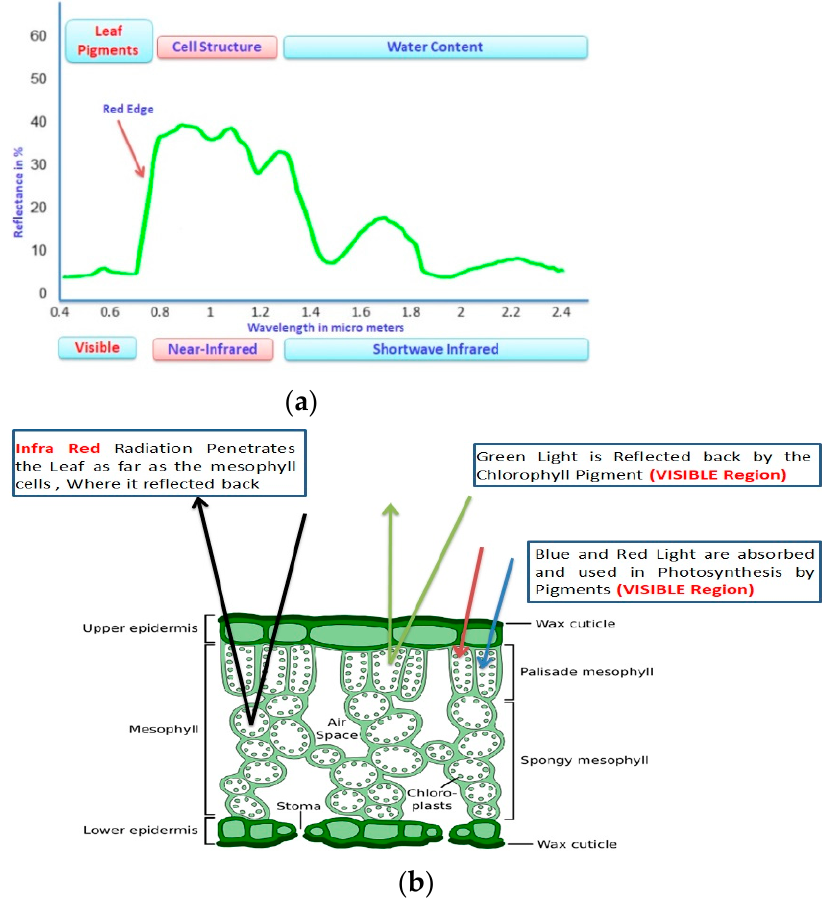
Figure 1. ( a ): Spectral Reflectance Properties of Vegetation Spectrum, ( b ): Leaf cell structure showing the interaction of light with VIS, NIR, and SWIR regions of the electromagnetic spectrum. The details of the measures used for the band selection, mathematical equations, range of the measures, and BS procedure are discussed in the Section 2.